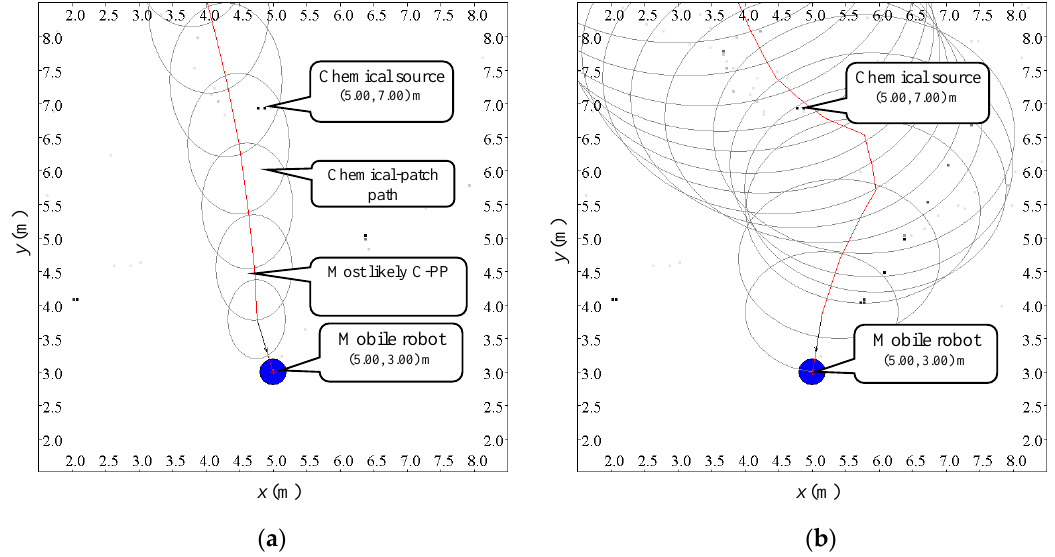
Figure 6. Two of the 100 estimated C-PPs when the distance between the robot and the source was 4 m and the threshold η in Equation (6) was chosen to be 10 − 2 m − 2 . The ellipses indicate the boundaries of areas OS ( t l , t j ) in Equations (5) and (6). ( a ) A case of the airflow being more stable ( [ σ 2 x , σ 2 y ] = [ 0.029,0.053 ] m 2 /s 2 ). ( b ) A case of the airflow being less stable ( [ σ 2 x , σ 2 y ] = [ 0.260,0.160 ] m 2 /s 2